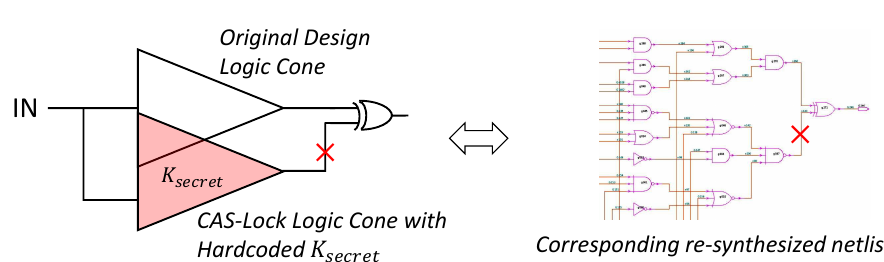
Figure 15: Gate-level netlist obtained after re-synthesis of a logic cone integrated with CAS-Lock with K